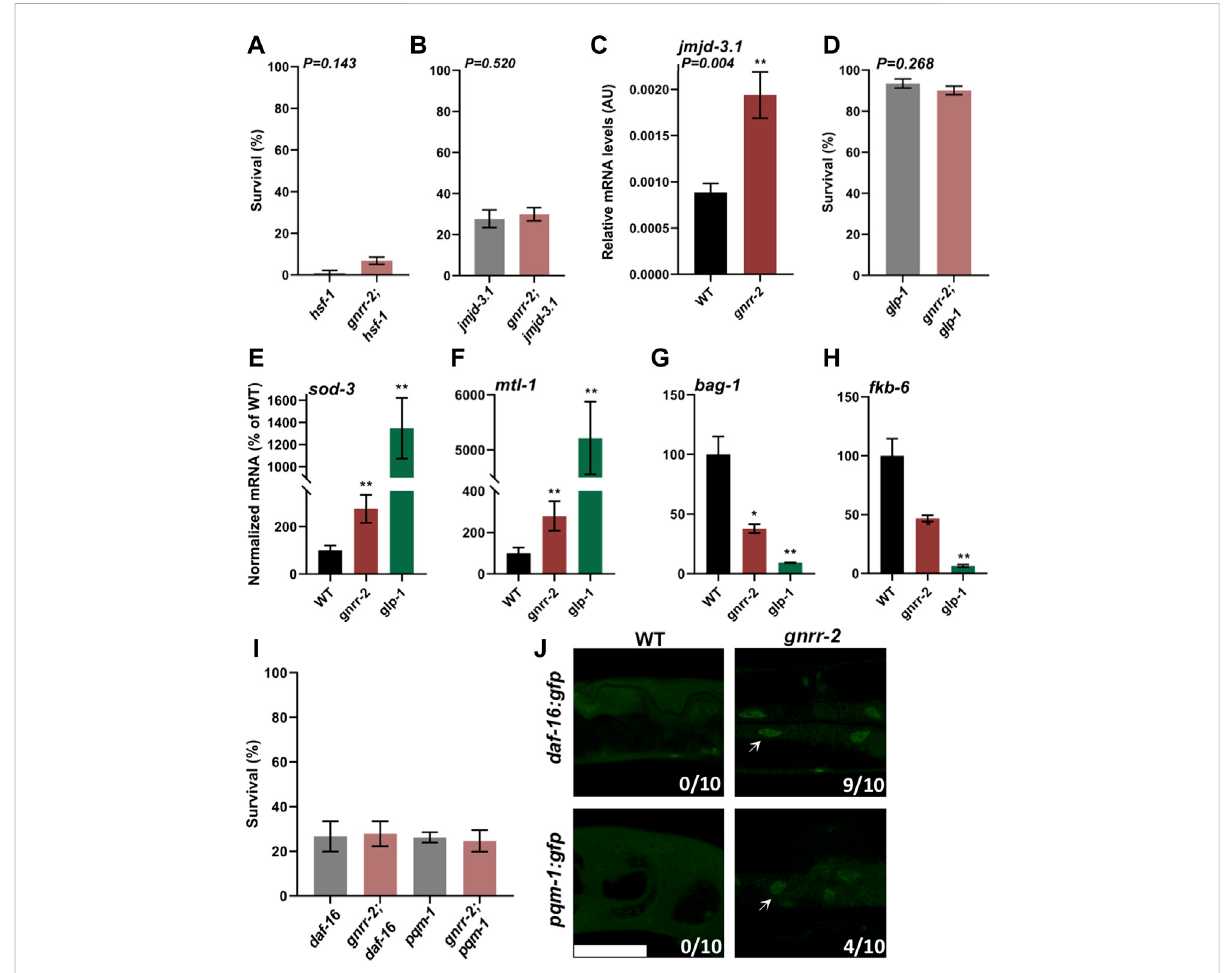
FIGURE 3 gnrr-2 requires HSF-1, DAF-16, and PQM-1 to modulate somatic proteostasis. (A,B) HS Survival rates of age-synchronized hsf-1(sy441) and gnrr-2;hsf-1 (A) or jmjd-3.1(gk384) and gnrr-2;jmjd-3.1 (B) mutant animals. Animals grown at 15 ° C (A) or 25 ° C (B) were subjected to HS (6 h at 37 ° C) on day two of adulthood, and survival was assayed ( N ≥ 6). Data are means ±1 standard error of the mean (1 SE). Data were analyzed using the Wilcoxon Mann-Whitneyrank sumtest ( p = 0.143 and p = 0.520,respectively). (C) jmjd-3.1 expression levels in age-synchronizedWT or gnrr-2 animals. mRNA wasextracted fromdaytwoadultanimals,and jmjd-3.1 mRNAlevels werequanti fi ed( N ≥ 5).Data aremeans±1standard errorofthe mean(1SE).DatawereanalyzedusingtheWilcoxonMann-Whitneyranksumtest( p =0.004). (D) HSSurvivalratesofage-synchronized glp-1 ( e2144 ) or gnrr-2 ; glp-1 mutant animals. Animals were subjected to HS (6 h at 37 ° C) on day two of adulthood, and survival was assayed ( N ≥ 5). Data are means±1standarderrorofthemean(1SE).DatawereanalyzedusingtheWilcoxonMann-Whitneyranksumtest( p =0.268). (E – H) Expressionlevels ofDAF-16orPQM-1 targets inage-synchronized WT, gnrr-2 ,or glp-1 animals. mRNA wasextracted fromdaytwoadultanimals,and mRNAlevels of sod-3 (E) , mtl-1 (F) , bag-1 (G) , and fkb-6 (H) were quanti fi ed ( N ≥ 5). Data are means ±1 standard error of the mean (1 SE). Data were analyzed using the Wilcoxon Mann-Whitney rank-sum test with Bonferroni correction. (*) denotes p ≤ 0.01 (**) denotes p ≤ 0.003 compared with same-age WT animals. (I) HS Survival rates of age-synchronized pqm-1 ( ok485 ) or daf-16 ( mu86 ) mutant animals in a WT or gnrr-2 background. Animals were subjected to HS (6 h at 37 ° C), and survival was assayed on day two of adulthood ( N ≥ 4). Data are means ±1 standard error of the mean (1 SE). Data wereanalyzed using one-wayANOVA followedbyaTukey ’ s post-hoc test. (J) Representativeimages of age-synchronizedanimals expressing